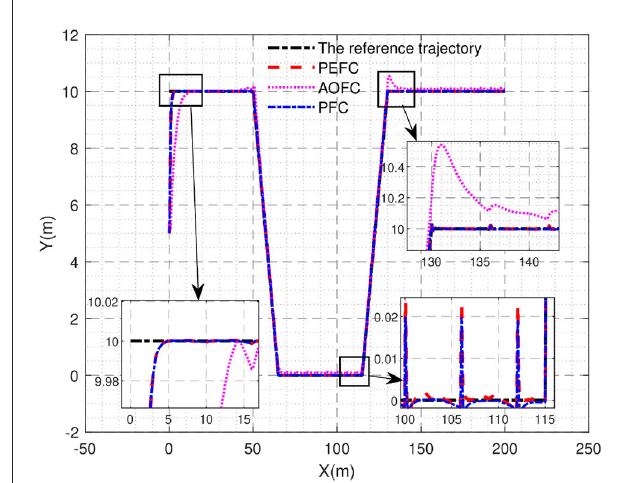
FIGURE5 Propeller failure curve. FIGURE6